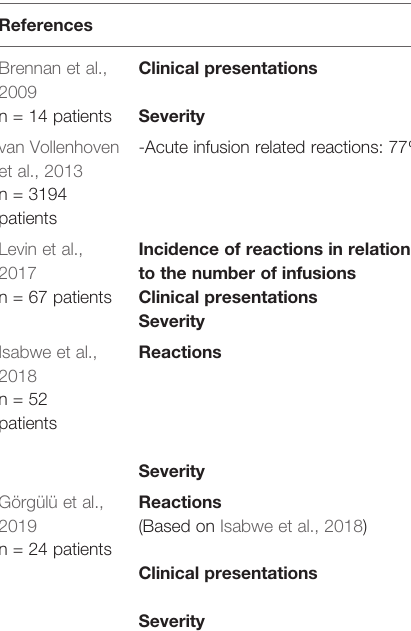
TABLE 2 | Prevalence and severity of HSRs to